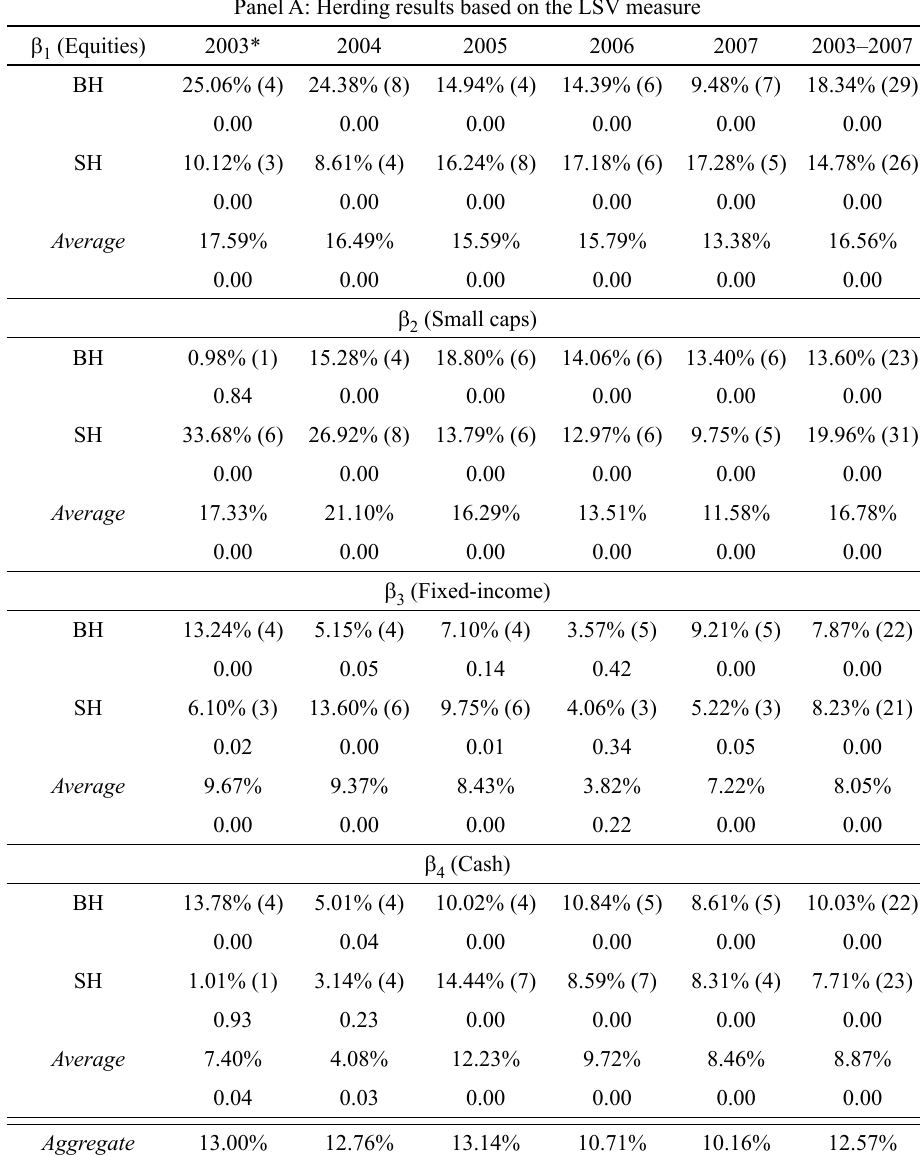
Table 4. Herding results based on the LSV measure Panel A: Herding results based on the LSV